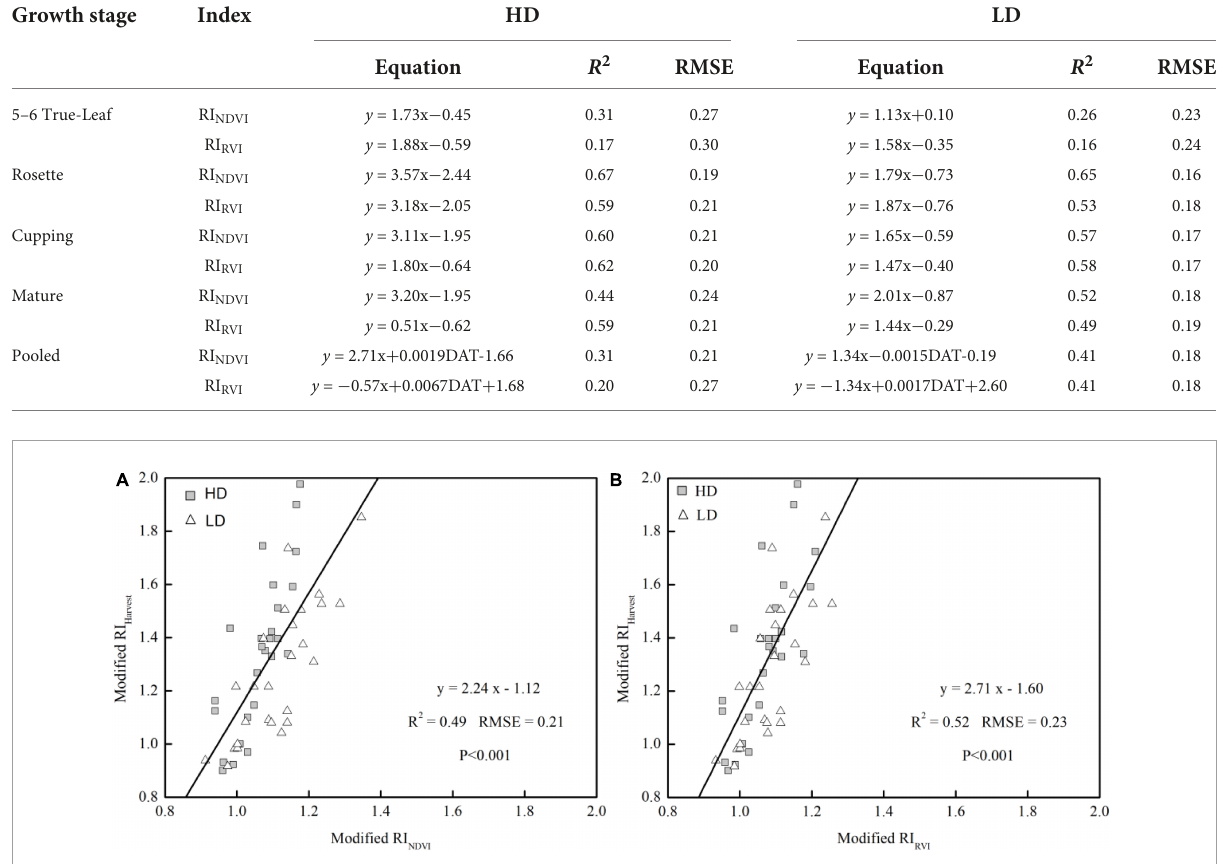
FIGURE4 Relationships between the response index calculated with yield (RI Harvest ) and the response index calculated with NDVI (RI NDVI ) (A) and RVI (RI RVI ) (B) at the rosette stage of bok choy growth in Years I, II, and